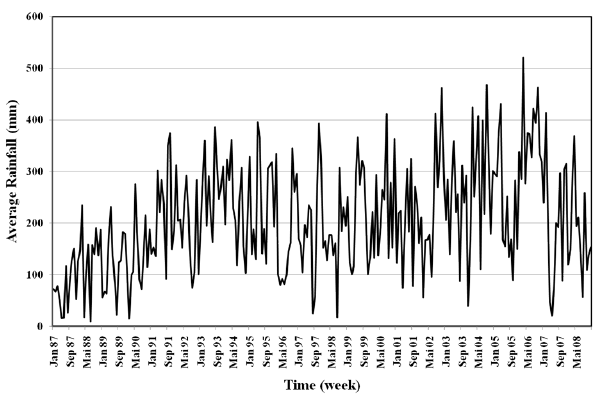
Figure 7: Monthly actual rainfall records on Klang River on for period 1987 - 2008 Fig. 7. Monthly actual rainfall records on Klang River on for period 1987–2008.